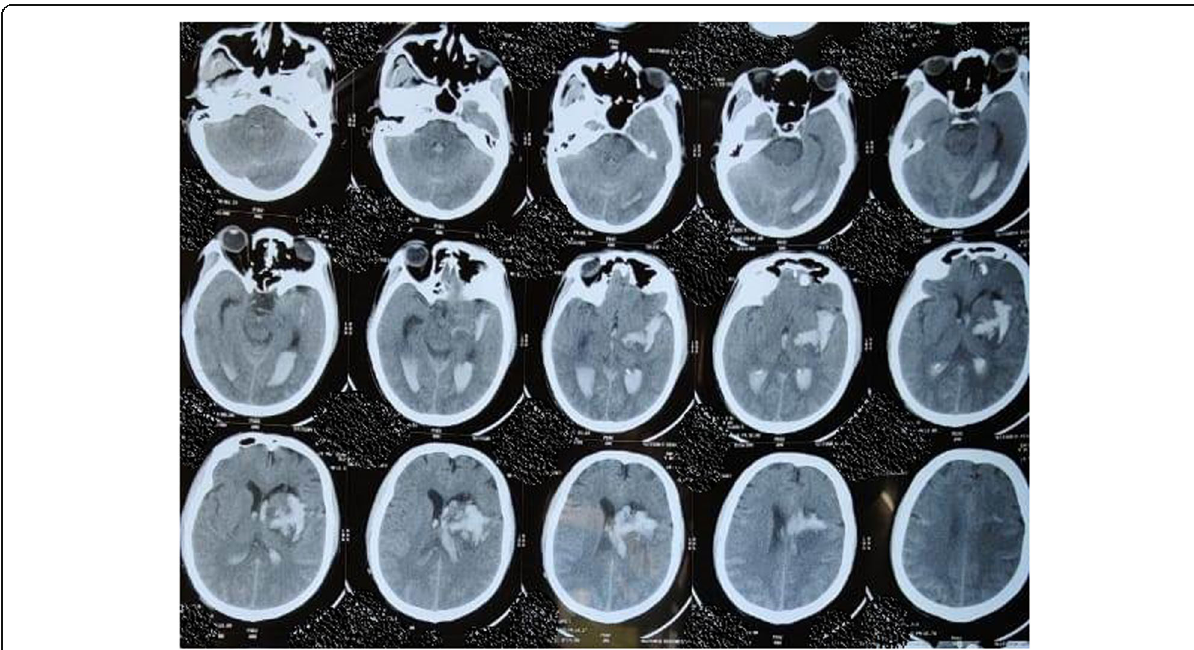
Fig. 2 NCCT head (axial sections) showing hyperdensities in left basal ganglia extending to left temporoparietal lobe, also involving the lateral ventricles — suggestive of intracerebral